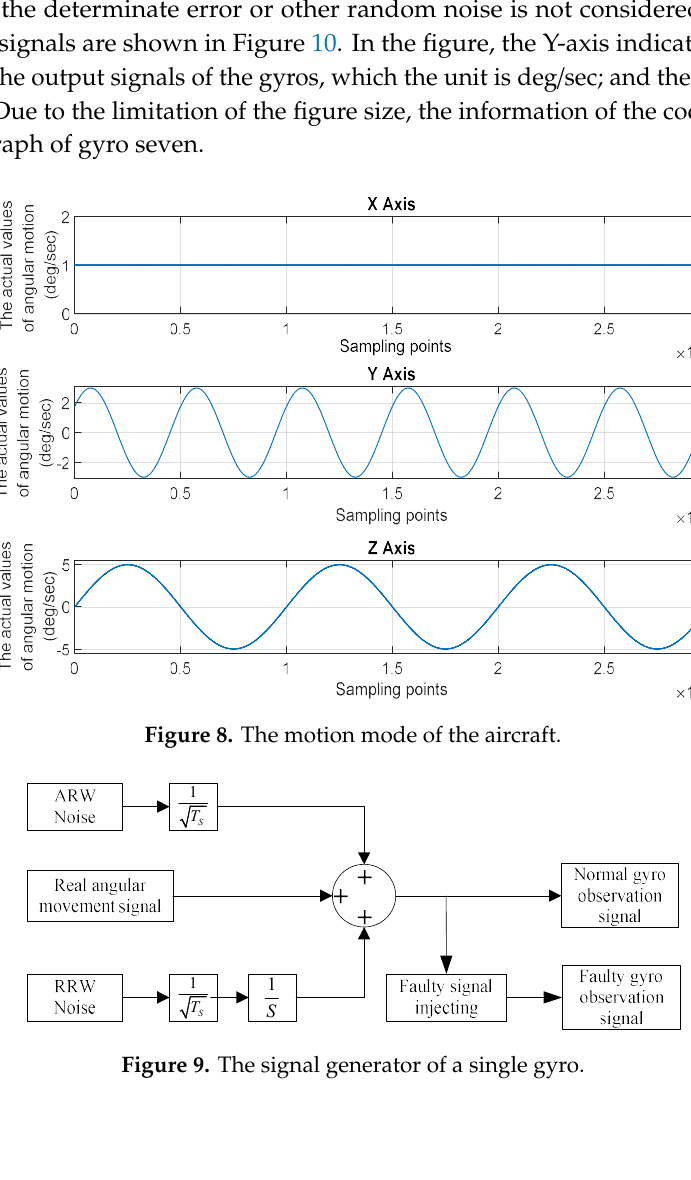
Figure 10. The output signals and noise. 6.2. The Experiments and Analysis 6.2.1. Single Anomaly To test the performance of the new method for the case of single anomaly, the outliers and the constant drift fault are injected into the normal measurement signal of gyro one in turn. The outliers are mutation anomalies that only exist a short duration. Injecting outliers is to verify the ability of tracking the quality changes of measurement data. The constant drift faults belong to the sustained anomalies, and the deviation caused by the constant drift is stable. Injecting the constant drift is to verify the ability of the correcting deviation. In the experiment, the deviation of the injected constant drift fault is 5  . Two kinds of anomaly signals are shown in Figure 11. The weighted LS, centralized Kalman filtering, weighted distributed Kalman filtering and the new method is used to produce the fusion signals, and the fusion results are shown in Figures 12 and 13.